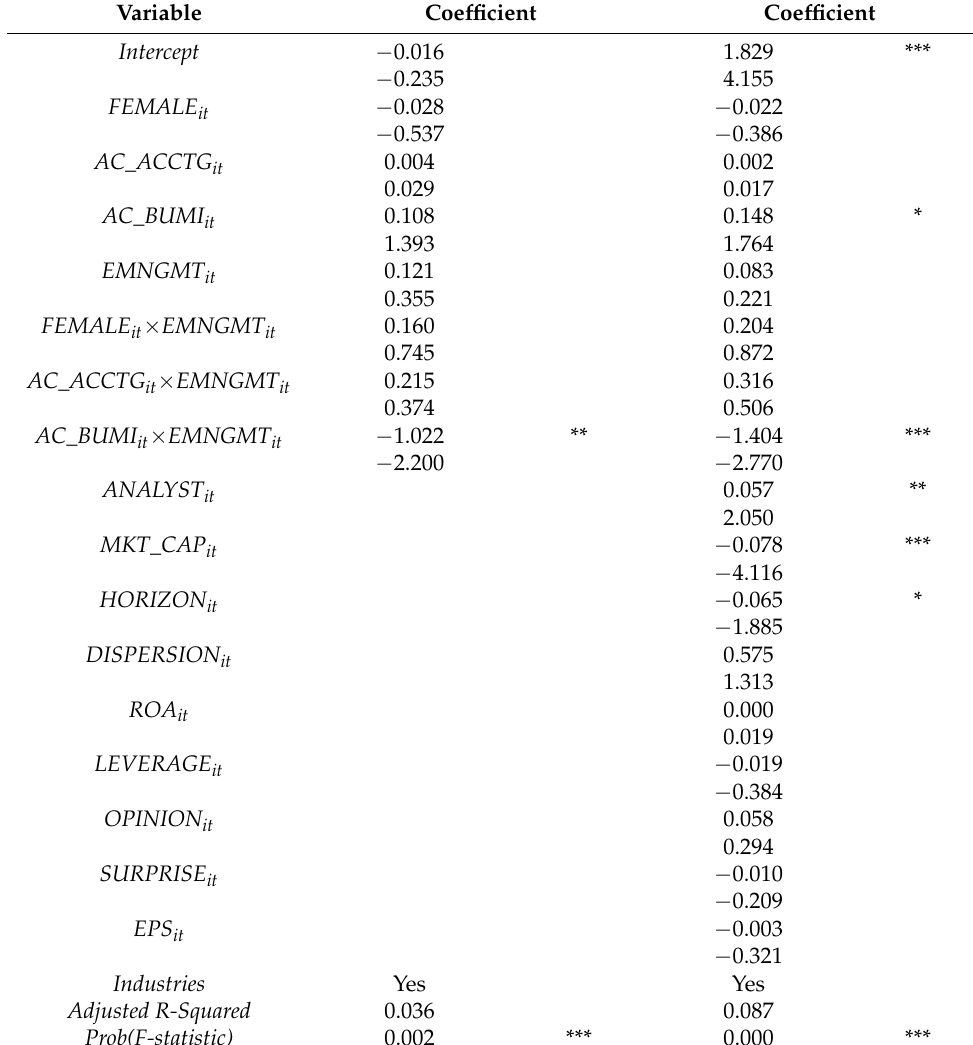
Table 7. Test Results of H4: Regression Analysis on the Interaction between Audit Committee Diversity and Earnings Management with Analyst Forecast